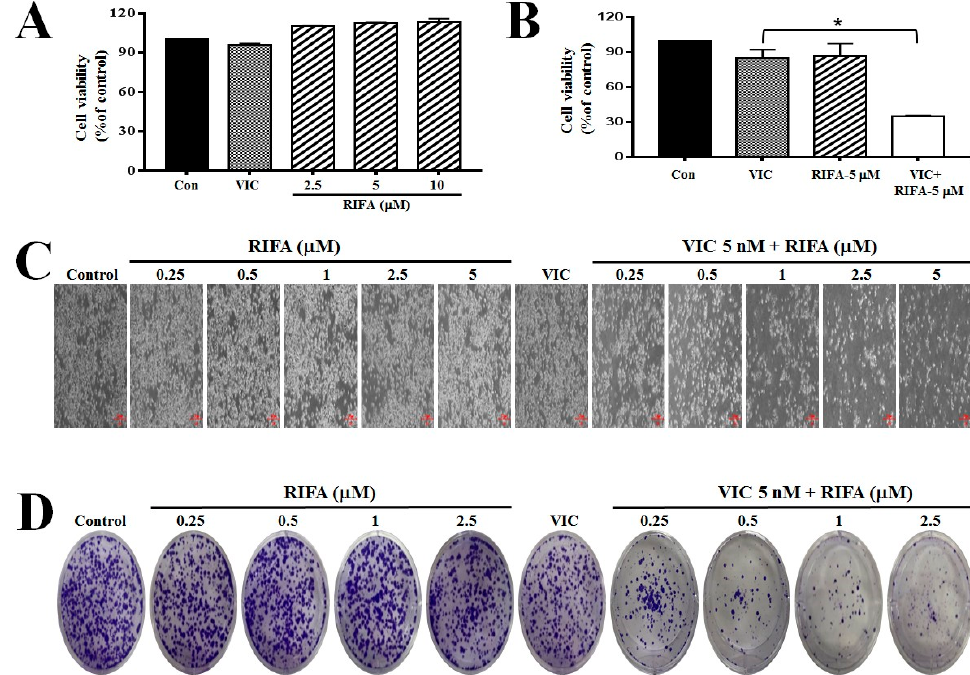
Figure 1. Rifabutin increases the cytotoxicity of VIC to P-gp-overexpressing drug-resistant KBV20C cancer cells. ( A , B ) KBV20C cells were treated with 5 nM VIC, indicated concentrations ( μ M) of rifabutin (RIFA), VIC + RIFA (5 μ M), or 0.1% DMSO (CON) for 48 h. Cell viability assay was performed. Data are presented as mean ± SD. * p < 0.05 was considered be statistically significant. ( C ) KBV20C cells were treated with 5 nM VIC, the indicated concentration ( μ M) of rifabutin (RIFA) alone, or in combination with 5 nM VIC, or 0.1% DMSO (Control). After 1 day, all cells were observed using an inverted microscope at ×40 magnification. ( D ) KBV20C cells were treated for 3 days with 5 nM VIC, indicated concentration ( μ M) of rifabutin (RIFA) alone, or in combination with 5 nM VIC, or 0.1% DMSO (Control). Colony forming assays were immediately performed with crystal violet staining after a total of 10 days.